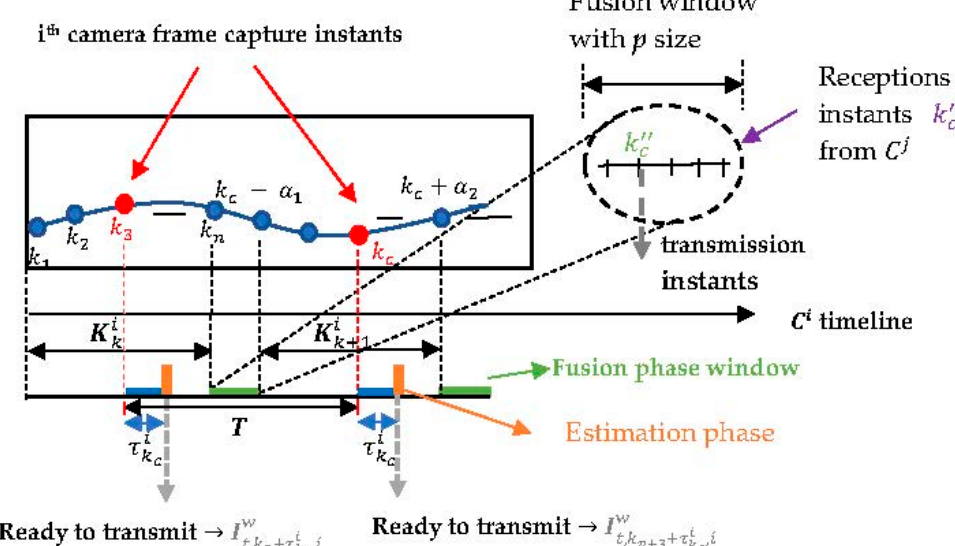
Figure 16. After each time window, the algorithm enters the fusion phase, where information is exchanged asynchronously within a fusion window with p size. k (cid:48)(cid:48) c is the transmission instant of C i , and k (cid:48)(cid:48)(cid:48) c represents the reception instants in C i from neighboring C j within the fusion window. Content exchanged within the fusion window: information pair ( (cid:101) y i , i fused 3D position measurement, and covariance ( 𝒛